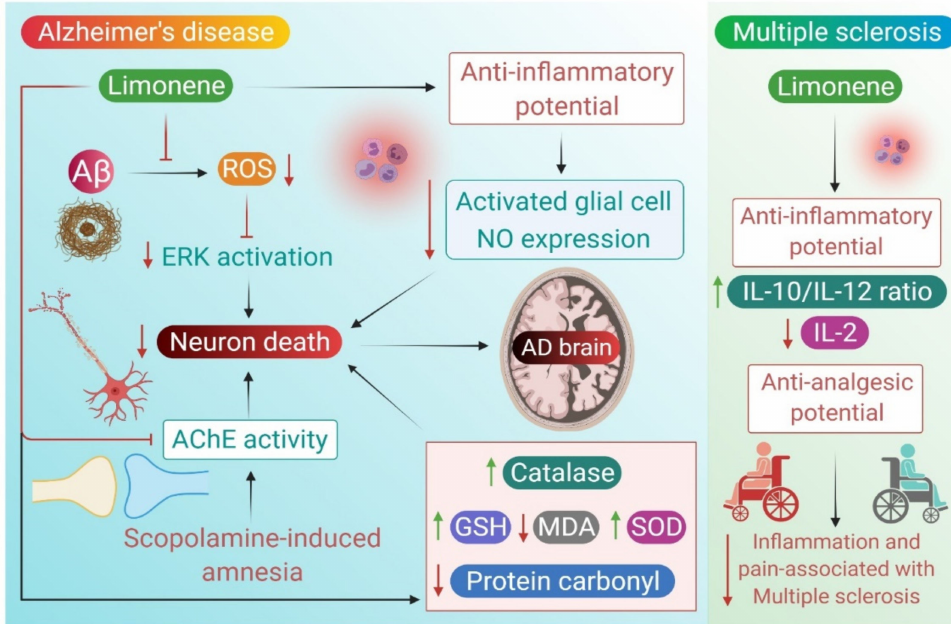
Figure 1. Neuroprotective mechanisms of limonene in Alzheimer’s disease and multiple